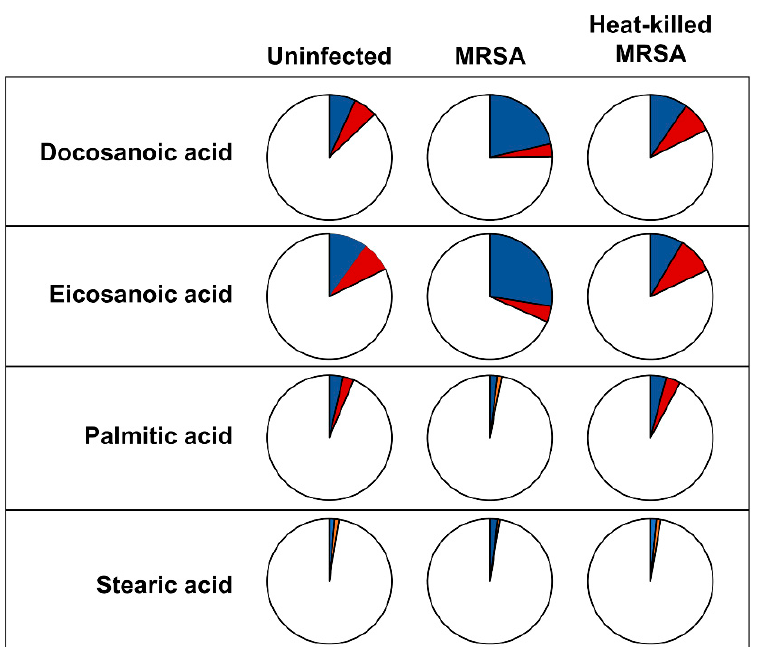
Figure 2. Labelling distribution of lipid-bound docosanoic, eicosanoic and palmitic acid is altered after intracellular USA300 infection. HeLa cells were infected with USA300 and exposed to heat-killed USA300 (MOI 100; 6 h) and labelling distribution was detected by GC-MS. Pie charts display the labelling pattern of transesterified fatty acids from uninfected cells (left pie-chart), cells infected with USA300 strain (middle pie-chart) and cells exposed to heat-killed USA300 (right pie-chart). Within pie-charts, blue slides represent carbon coming from labelled glucose, whereas red slides are carbon coming from labelled glutamine and white slides show carbon from other sources.